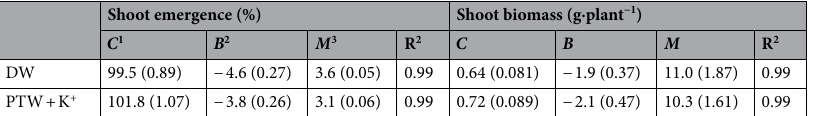
Table 2. Parameter estimates for the logistic model for the regression of the Panax ginseng shoots, each sprayed with deionized water (DW) and plasma-treated water (PTW) containing potassium ions (K + ) up to 25 days after planting. 1 C represents the maximum shoot emergence or shoot biomass. 2 B is the rate of increase of the shoot emergence or shoot biomass. 3 M is the time lag to reach 50% of the maximum cumulative shoot emergence or shoot